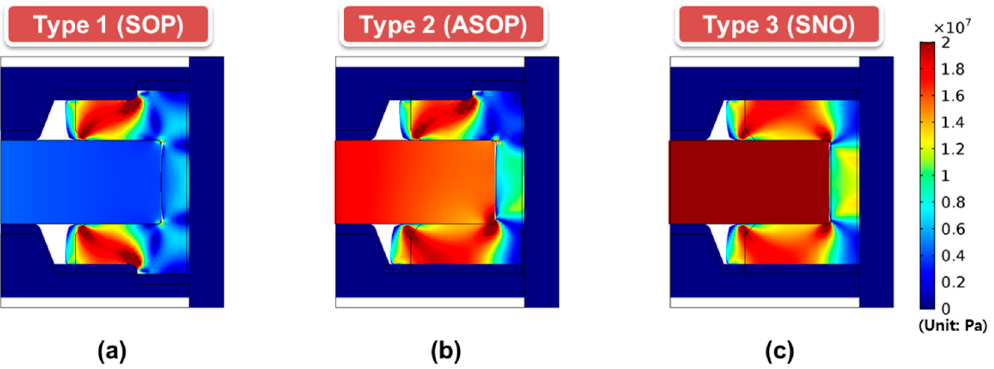
Figure 7. UMS deformations and equivalent stress distributions under radial compression due to an internal pressure of 10 MPa for TR = 1.0: ( a ) type 1; ( b ) type 2; and ( c ) type 3. SOP: symmetric open groove; ASOP: asymmetric open groove; SNO: symmetric no groove.